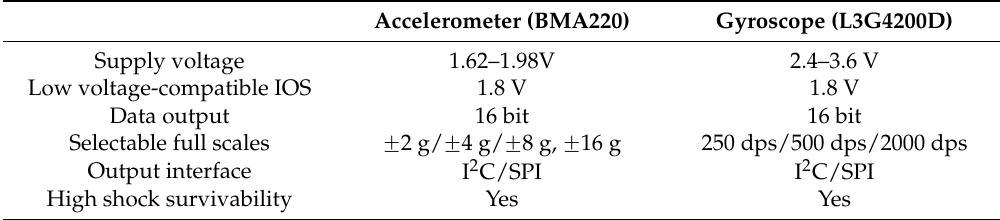
Table 1. Basic features of the accelerometer and gyroscope in the iPhone.